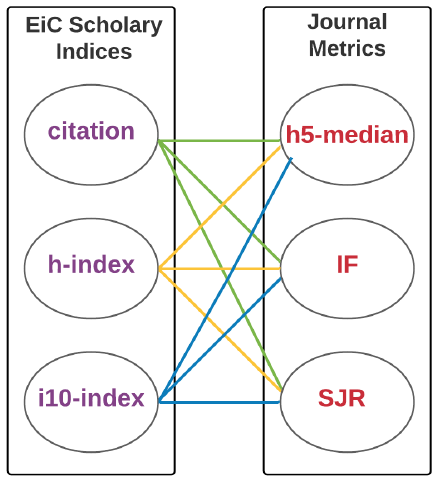
Figure 3. Pairs of EiC and journal scientometric indices used for correlation